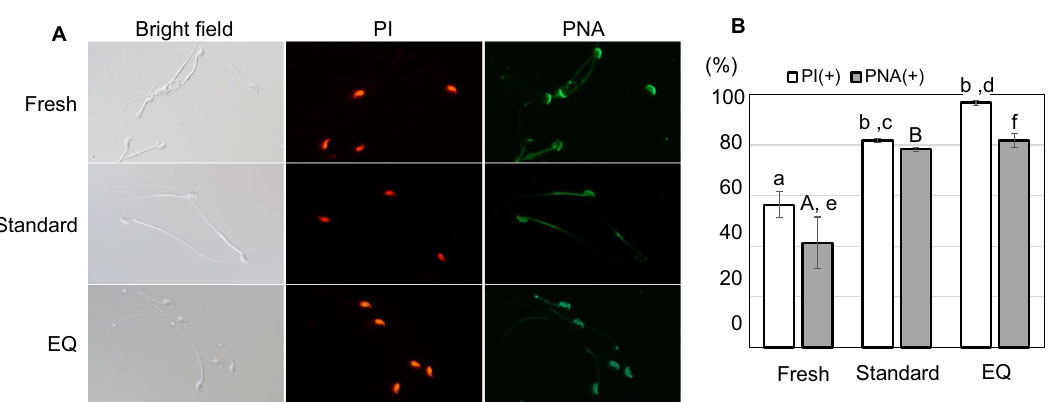
Figure 6. Visualization of plasma membrane integrity and the acrosomal status. ( A ) Representative images of fresh and frozen–thawed spermatozoa by standard and EQ methods after staining using propidium iodide (PI; red) and peanut agglutinin (PNA; green). ( B ) The percentages of spermatozoa stained by PI ( +) and PNA ( +). Significant difference indicated by different superscript letters. ( a, b; c, d; e, f P < 0.01, A, B P < 0.05 by Tukey–Kramer test).